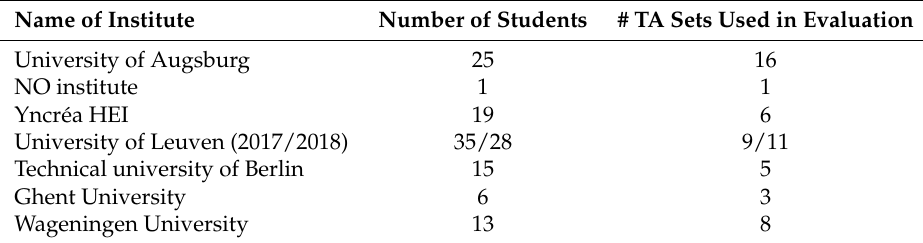
Table 3. Participants and cities in the HUMan INfluence